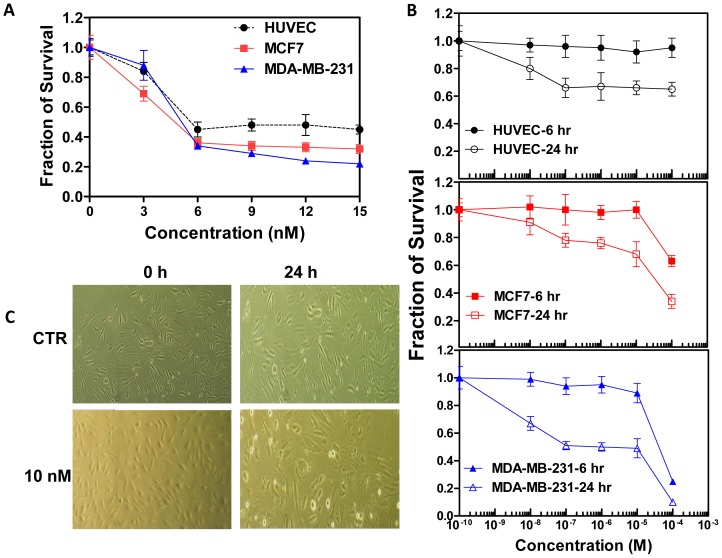
Inhibition of cell proliferation by BPR0L075.(A) Proliferating human umbilical vein endothelial cells (HUVEC), and breast cancer (MCF7 and MDA-MB-231) cells were treated with BPR0L075 at various concentrations (0–15 nM) for 96 hours and the viable cells were stained with sulforhodamine B. (B) HUVEC and tumor cells were treated with BPR0L075 at various concentrations for 6 hours and 24 hours and cytotoxicity was evaluated by SRB assay. Fraction of cell survival relative to controls represents mean ± SD of 16 determinations. (C) Representative photomicrographs show the morphology of HUVEC cells in the presence of ethanol vehicle or 10 nM BPR0L075 in medium. All experiments were repeated three times.